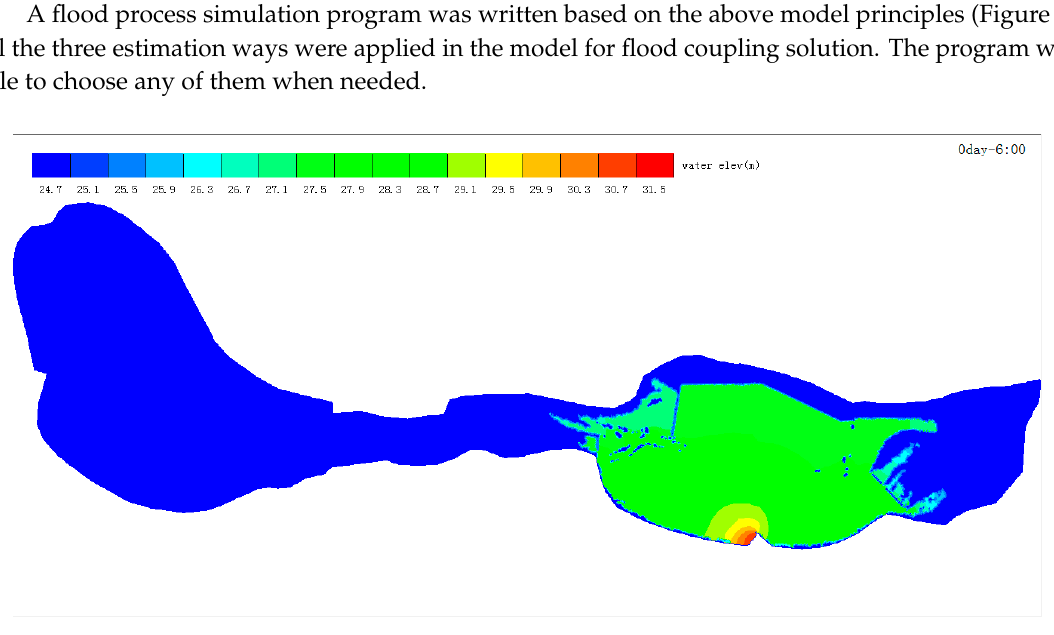
Figure 8. Calculated flood depth. 3.3. Construction of Building Flood Loss Rate Curves Different building materials vary in their ability to withstand floodwater, which is reflected in building flood loss rates, making it necessary to classify all buildings in the study area. 3.3.1. Building Classification As a typical rural area in the middle reaches of the Yangtze River, the buildings in Gongshuangcha consist of two main types: brick–concrete (Figure 9a) and brick–wood (Figure 9b). The former are mainly distributed in township municipal centers while the latter are widely distributed in rural residential areas; these are the most numerous and typical in the study area.